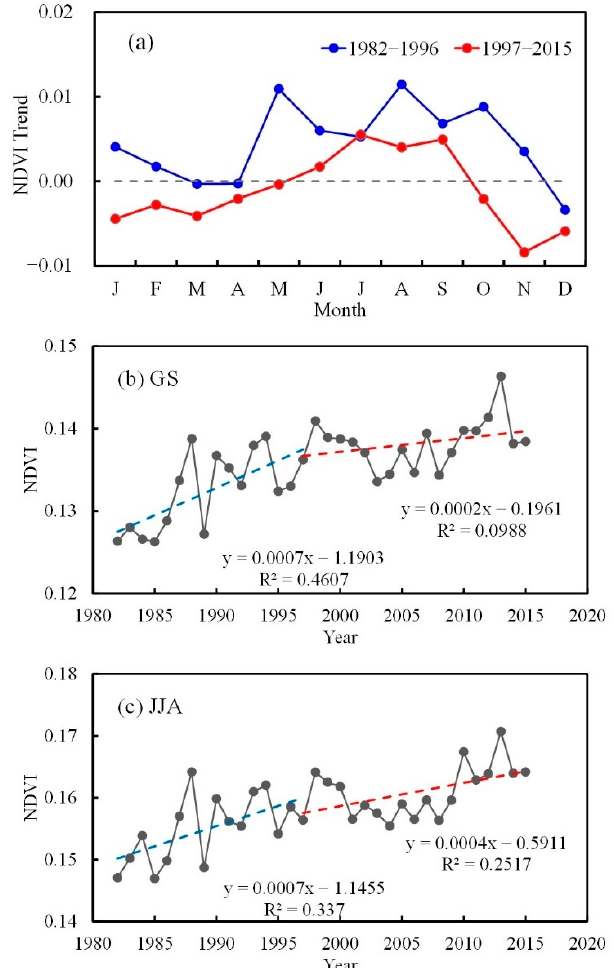
Figure 4. Change in the NDVI trends over Xinjiang, China, from 1982 to 2015. ( a ) Mean monthly NDVI trends between the two periods of 1982–1996 and 1997–2015. ( b , c ) Time series of NDVI over the GS and JJA.